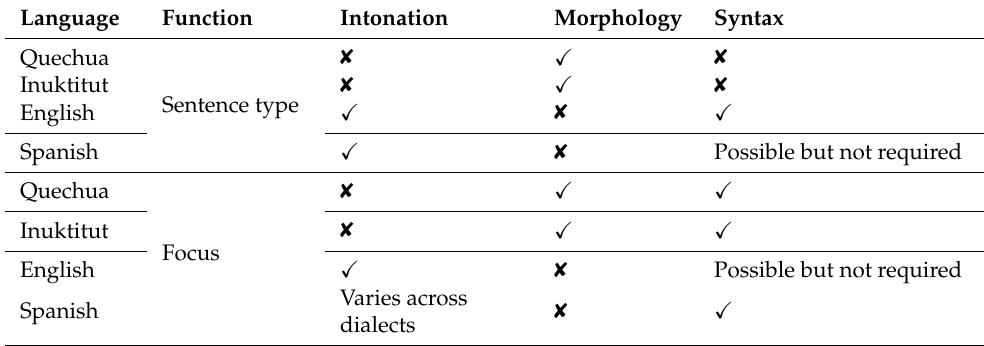
Table 4. Summary of the language components interactions for the marking of sentence types (statements vs. absolute yes/no questions) and focus (narrow and contrastive).